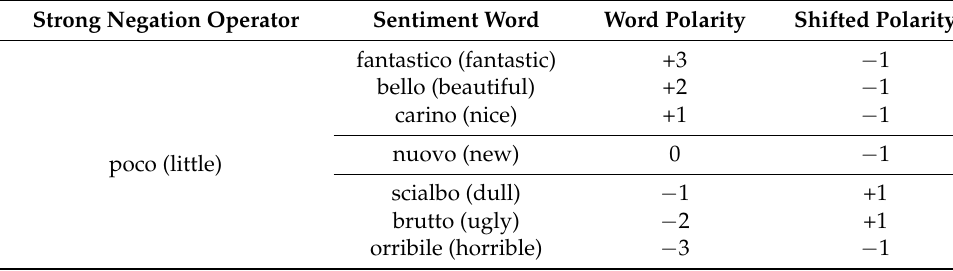
Table 4. Negation rules with weak